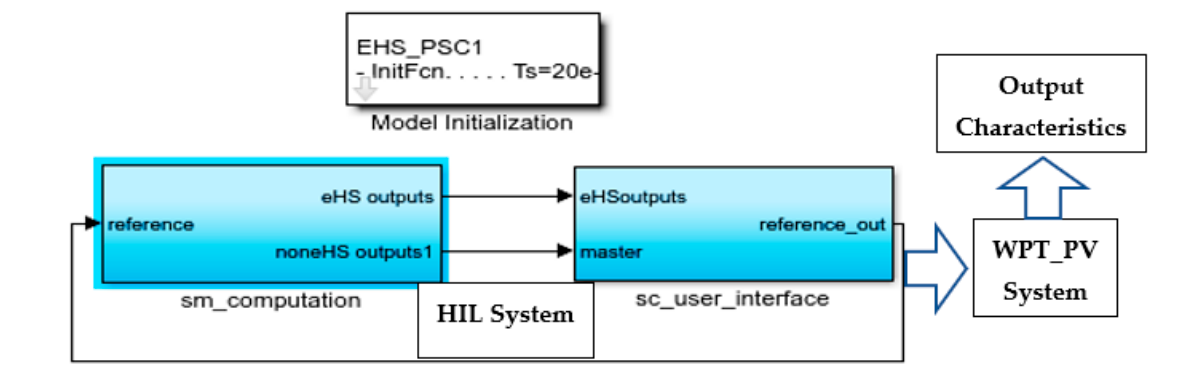
Figure 23. OPAL-RT testing experiment.